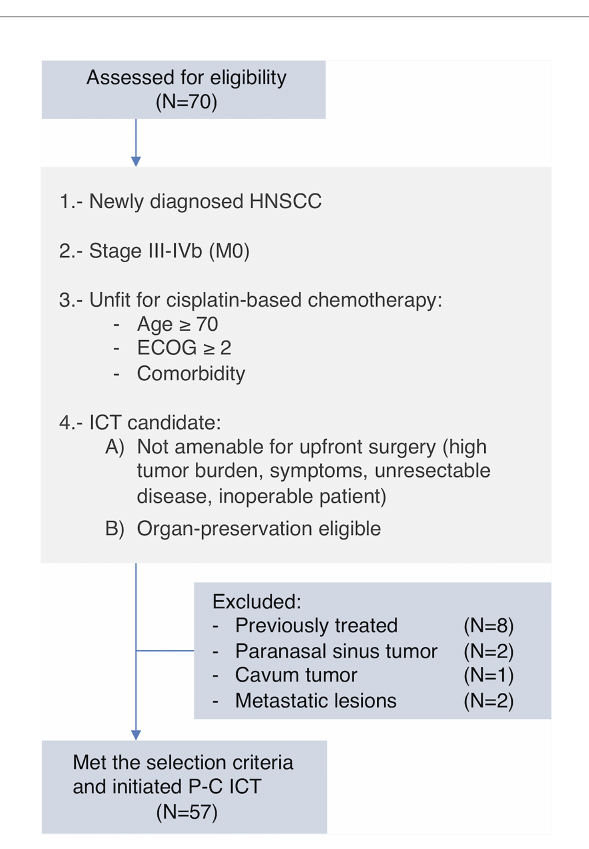
Table 2 . Most patients were male (91.2%) and ≥ 70 years old